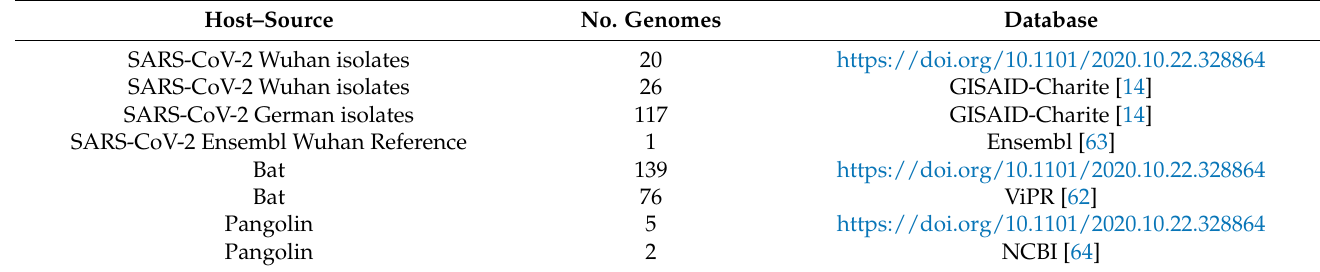
Table 2. Coronavirus genomes were collected from the various database resources listed by host and source categories. Using taxonomic data made available by the Virus Pathogen Database and Analysis Resource (ViPR) [62], 70 bat-CoVs were identified as Betacoronavirus and 84 were Alphacoronavirus . Five pangolin-CoVs were identified as Betacoronavirus . The remaining bat-CoV and pangolin-CoV genomes did not have a family identification. These were downloaded in May 2020 and consisted of the contemporary available and open datasets at the time. All genomes and their respective IDs are currently available through NCBI (Oct 2020). In cases where two groups contained the same genome (Possibly with a different name), only one representative was